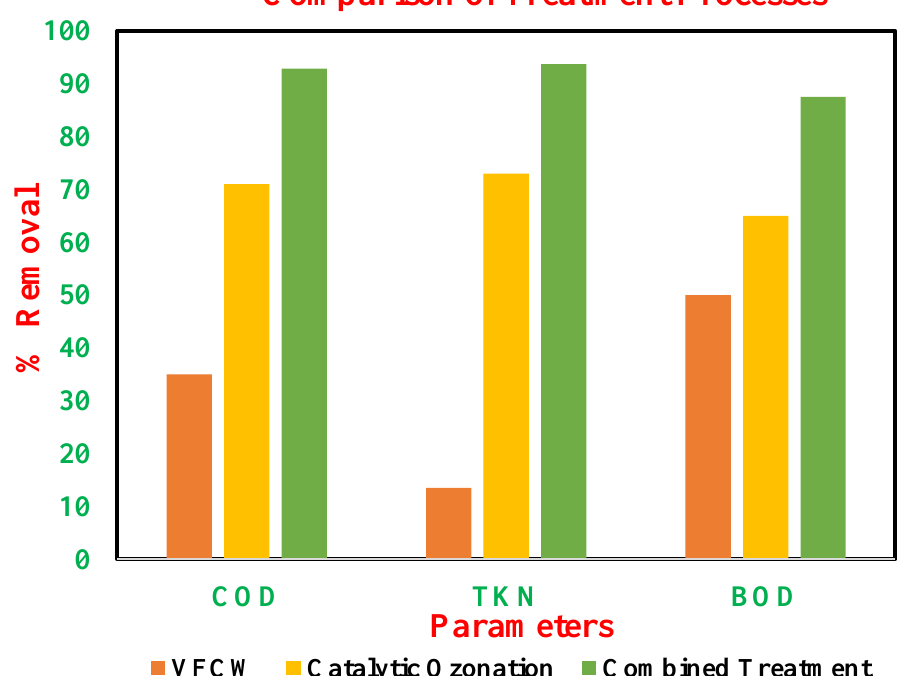
Figure 8. % Removal of COD, TKN and BOD 5 from VF and catalytic ozonation (Catalyst dose = 0.25 g; O 3 = 1.8 mg/min; t O3 = 60 min; t RT = 3.5 hrs.; T = 18 °C).